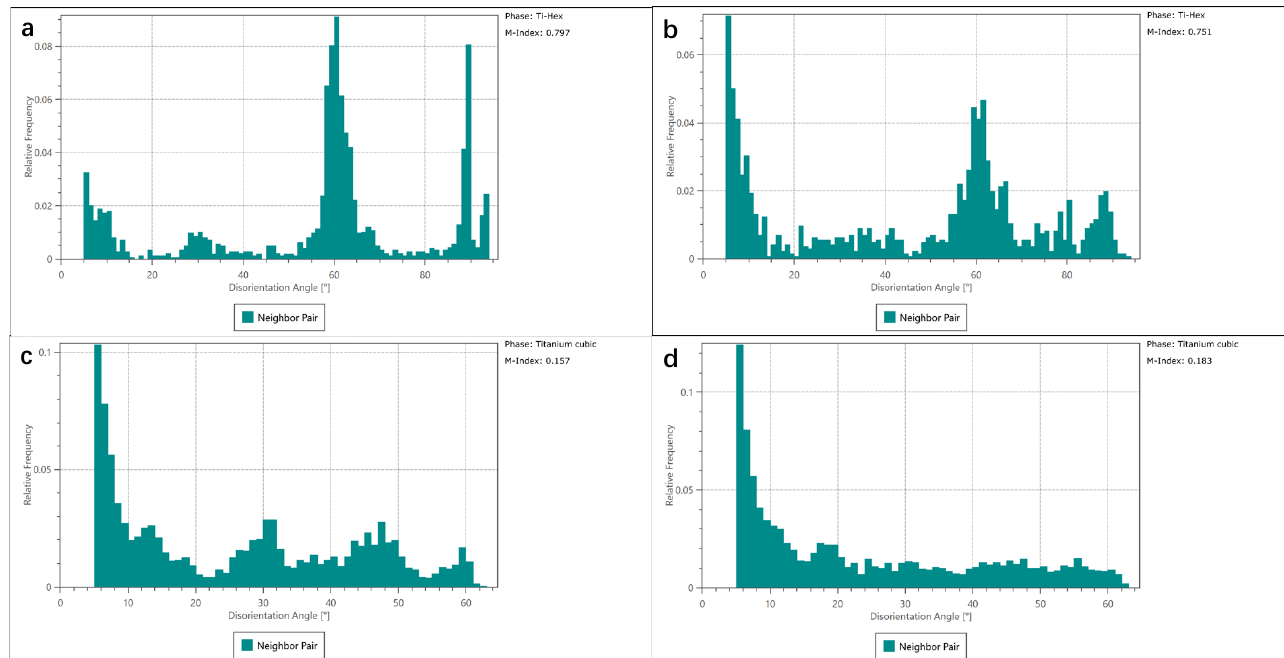
Figure 8. EBSD analysis of HAZ area of as-LMD and LMD+LSPned samples. ( a , b ) IPF Z mappings; ( c , d ) phase mappings; ( e , f ) KAM mappings; ( g , h ) pole figures for hcp and cubic phase. ( i , j ) pole figures for cubic phase.